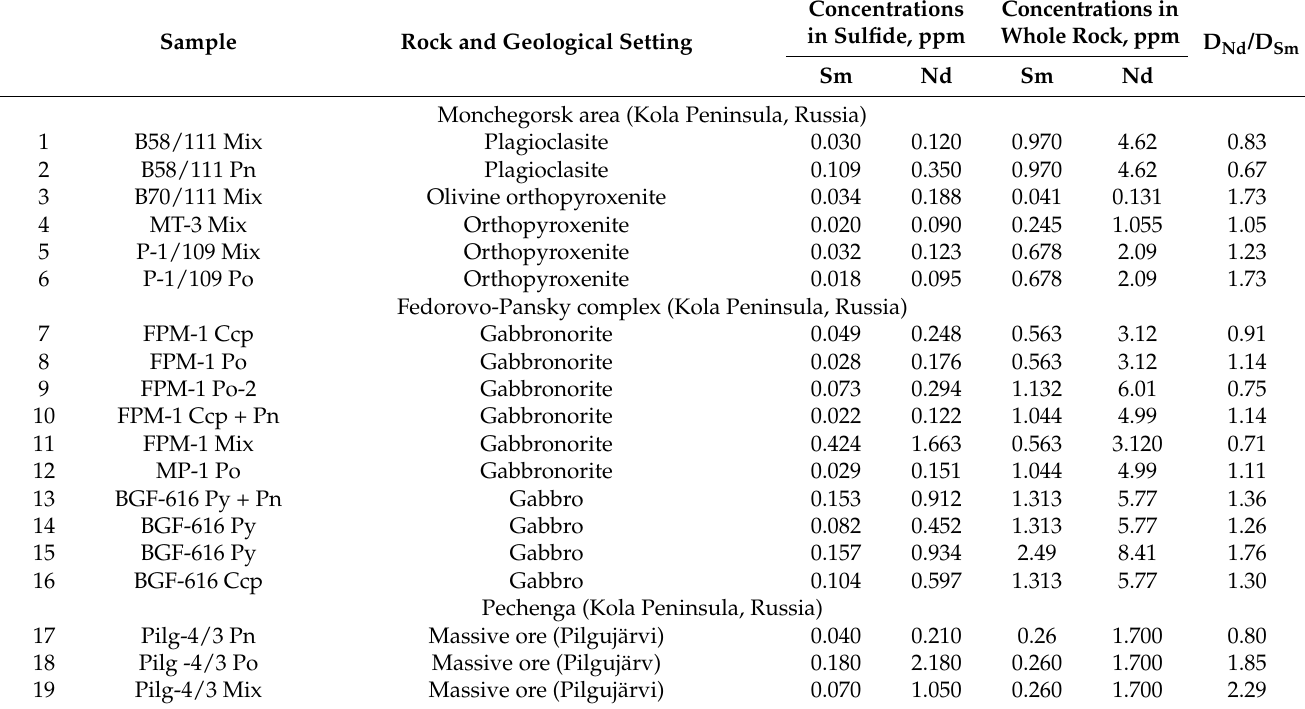
Table 1. Neodymium and samarium concentrations in sulfide minerals from the magmatic and hydrothermal complexes and the respective D Nd /D Sm ratio